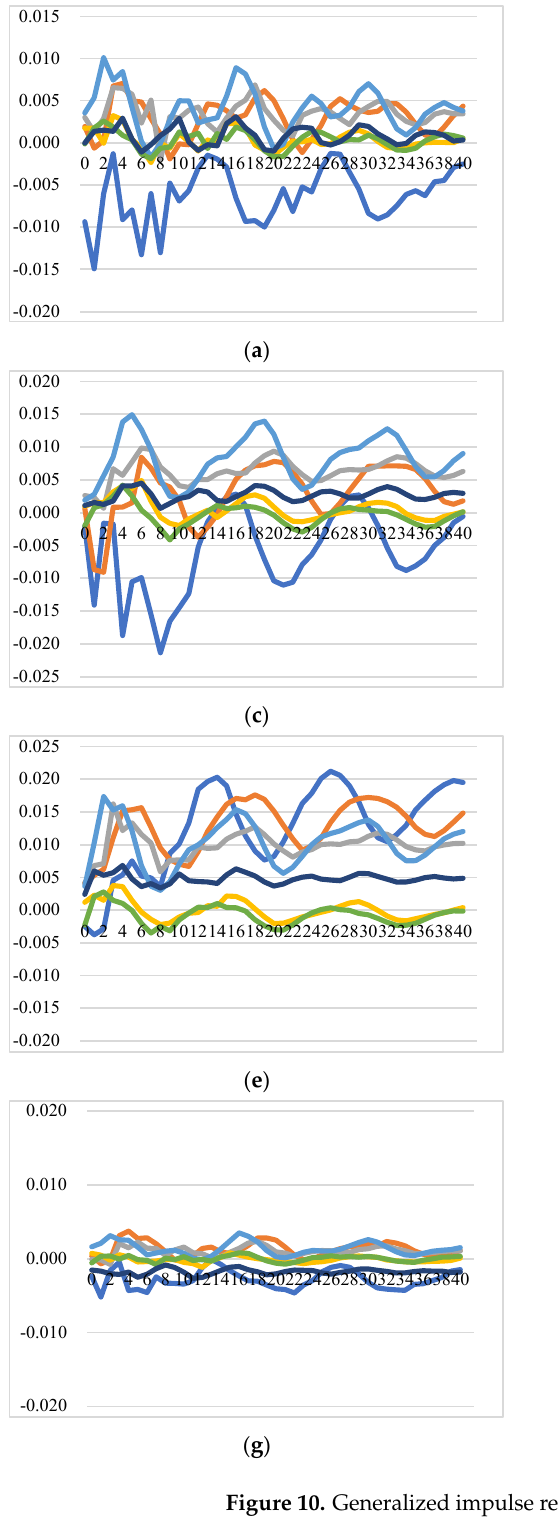
Figure 10. Generalized impulse response functions (GIRFs) of six EU member states’ extra-EU cheese export prices after a positive one-standard-error shock to raw milk price (bootstrap median estimates). ( a ) GIRFs after a shock to France’s raw milk price. ( b ) GIRFs after a shock to Germany’s raw milk price. ( c ) GIRFs after a shock to Ireland’s raw milk price. ( d ) GIRFs after a shock to Italy’s raw milk price. ( e ) GIRFs after a shock to the Netherlands’ raw milk price. ( f ) GIRFs after a shock to the UK’s raw milk price. ( g ) GIRFs after a shock to the rest of the EU’s raw milk price. ( h )